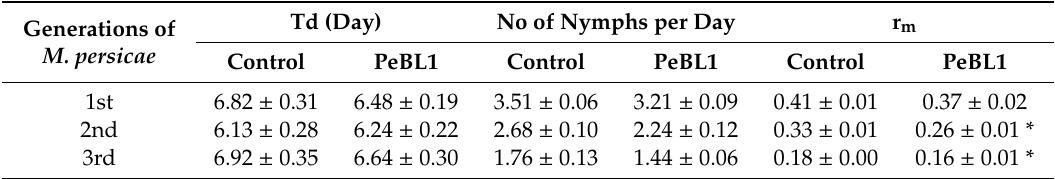
Table 1. M. persicae settled population data in PeBL1-treated, control, and buffer-treated cucumber seedlings showed differences of M. persicae number after every 5, 10, and 15 days. Days after Aphid Inoculation